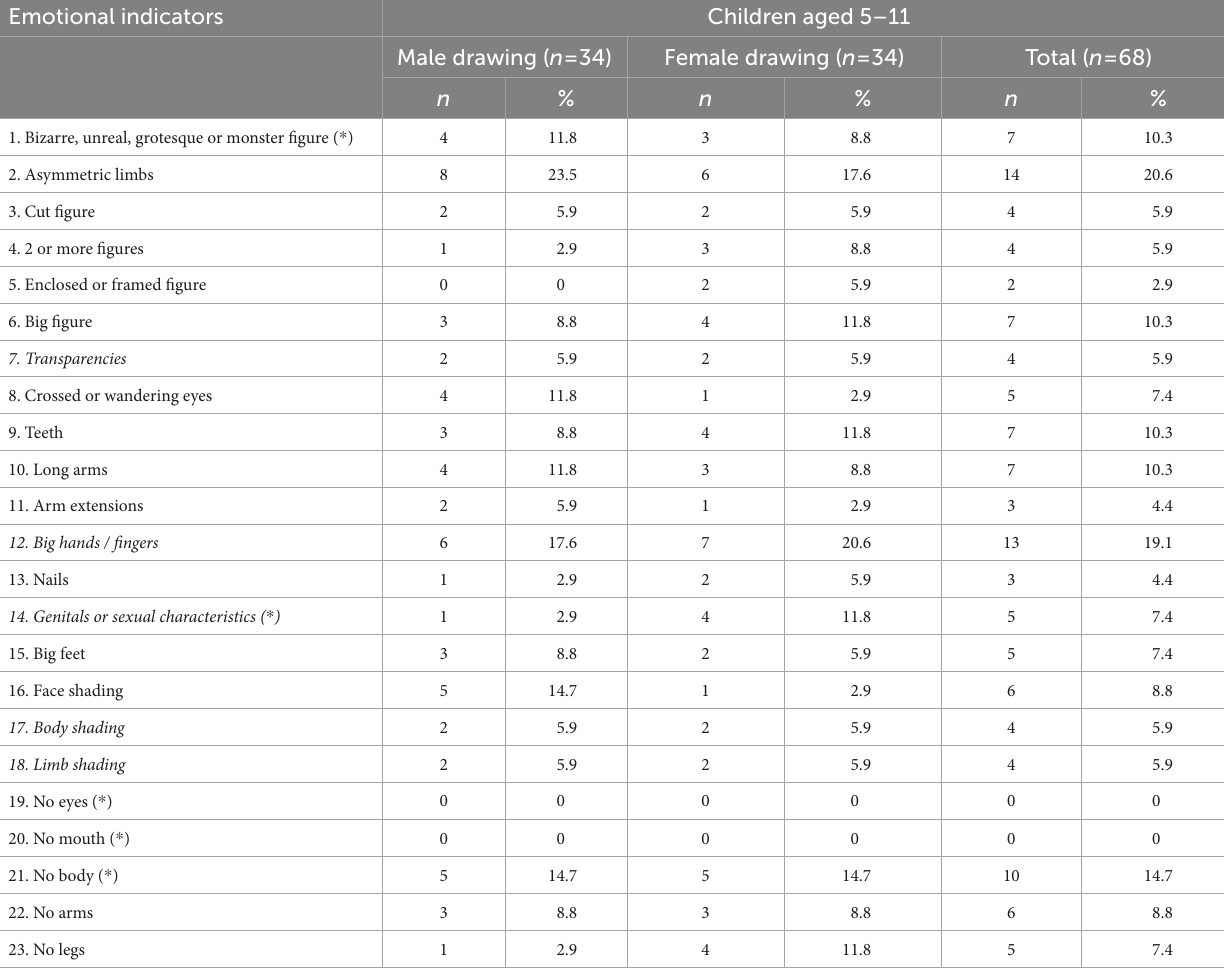
TABLE 4 Frequencies of emotional indicators common to all ages in Two Human Figure test